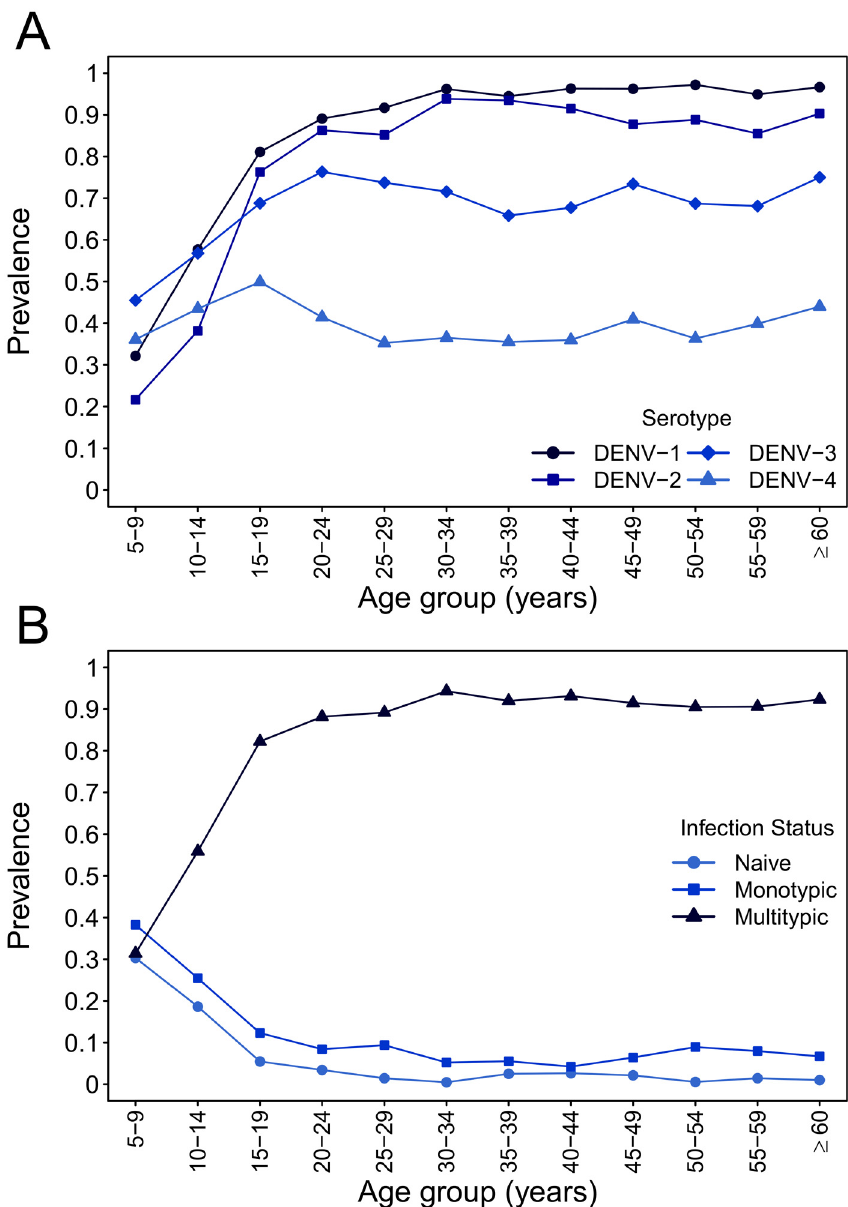
Fig 1. Age distribution of DENV neutralizing antibodies in 2010. Samples were collected between March and June 2010, approximately 6 months prior to a large dengue epidemic largely caused by American/Asian genotype DENV-2. Panel A: Age distribution of serotype-specific DENV neutralizing antibodies. Panel B: Age distribution of number of prior DENV infections. Na ï ve indicates absence of detectable DENV neutralizing antibodies against any serotype, monotypic indicates DENV neutralizing antibodies against one serotype, and multitypic indicates DENV neutralizing antibodies against two or more serotypes.